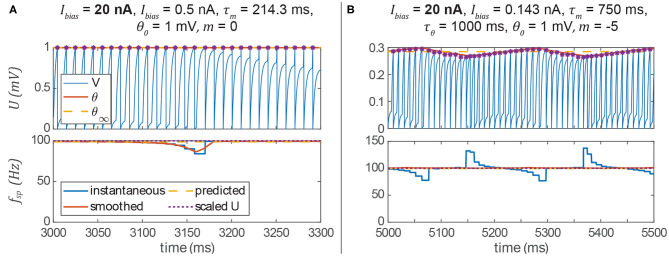
(A) If a pre-synaptic spike does not elicit a spike in the post-synaptic neuron, then its spiking frequency will intermittently drop. (B) The spiking frequency of a post-synaptic neuron whose threshold hyperpolarizes in response to membrane voltage depolarization may oscillate at low frequencies. In both columns, spikes are indicated by violet asterisks (no cosmetic “spikes” are plotted).